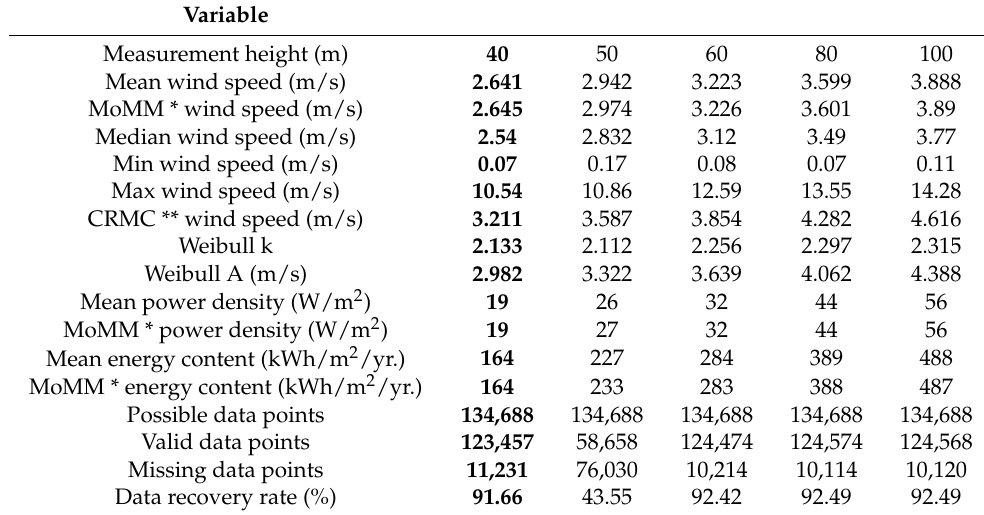
Table 2. Summary of LIDAR wind measurements (233 m far from the wind turbine location).